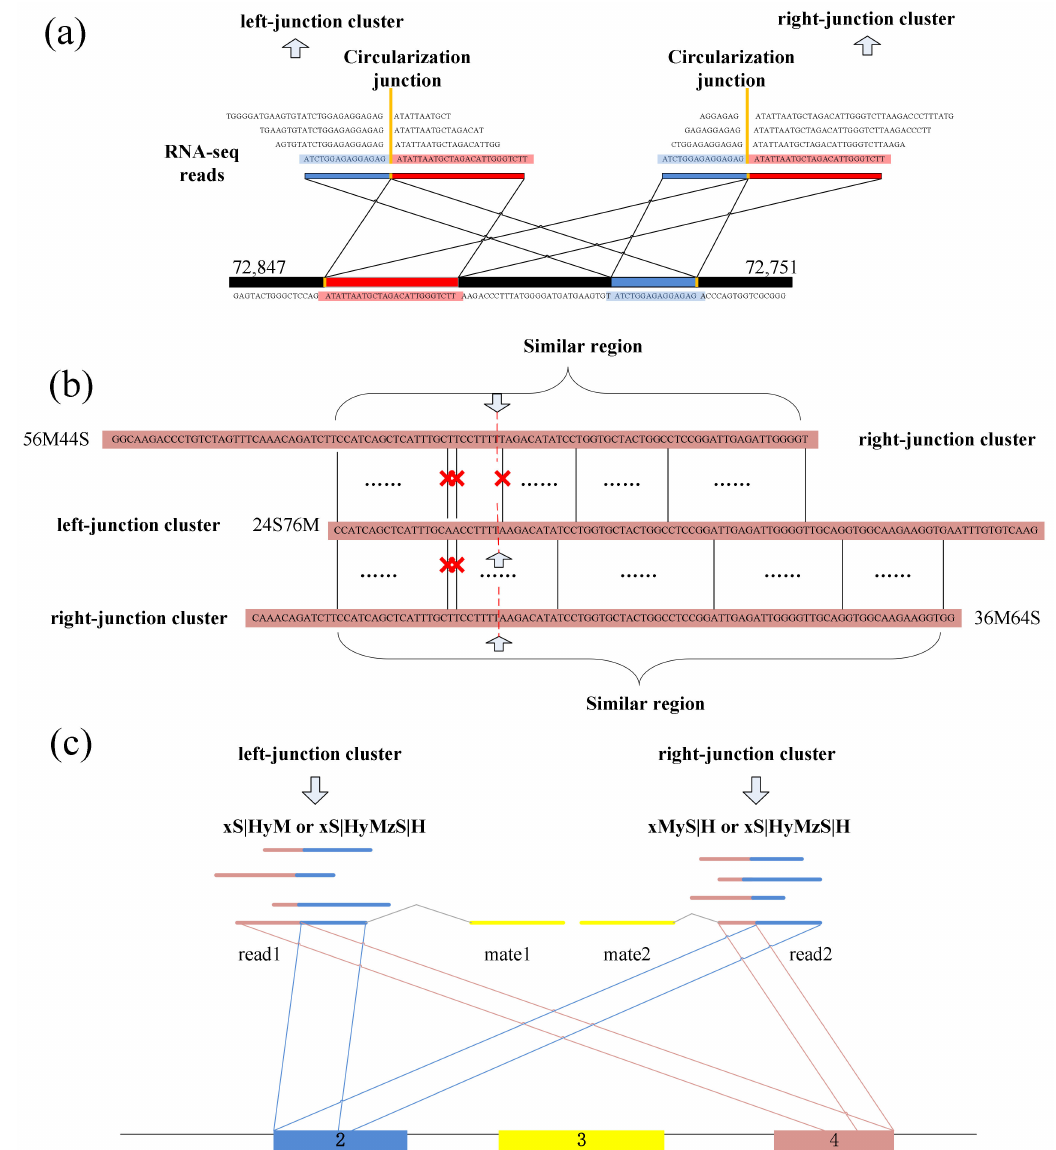
Figure 6. ( a ) A read from left-junction cluster should have a similar sequence with a read from right-junction cluster. ( b ) Two reads from two clusters are accepted during the detection. A red cross denotes a mismatch base-pair in the similar region. ( c ) Clustering the BSJ reads within a